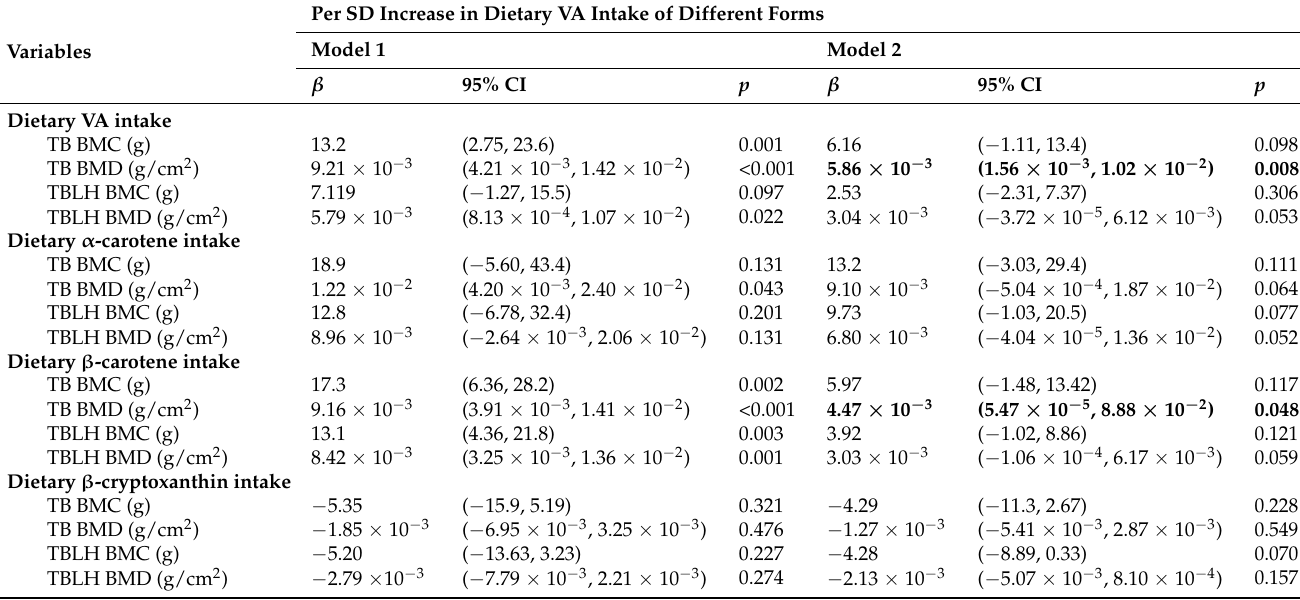
Table 2. Multiple linear regression analysis between dietary VA intake and bone mineral